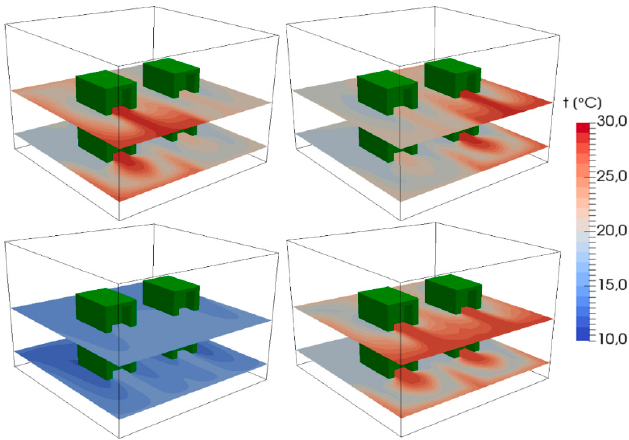
Figure 9. Various scenarios of air volumetric flow value with other parameters preserved constant; top-left: 1 m 3 /s, top-right: 2 m 3 /s, bottom-left: 3 m 3 /s, bottom-right: 4 m 3 /s.